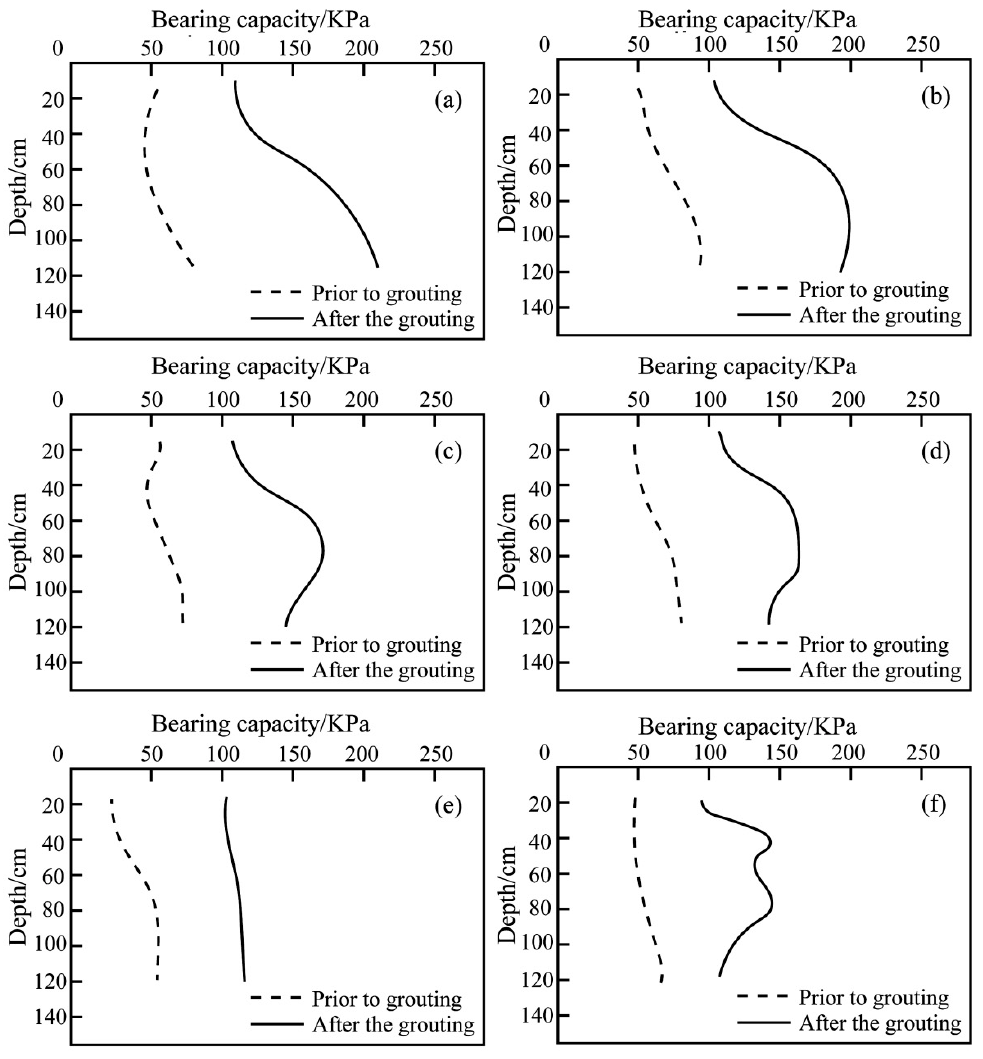
Figure 15. Change of bearing capacity of dynamic penetration test points. ( a ) Point 1, ( b ) point 2, ( c ) point 3, ( d ) point 4, ( e ) point 5, and ( f ) point 6.